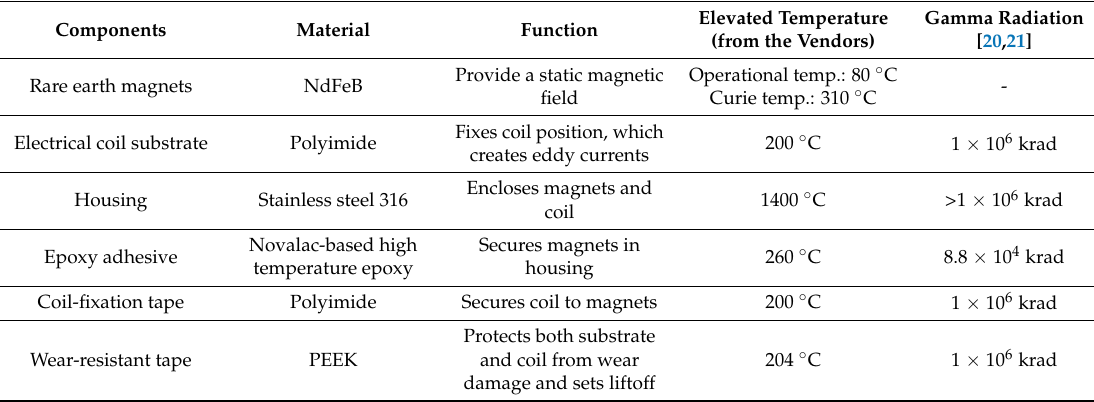
Table 1. EMAT components selected for their harsh environmental